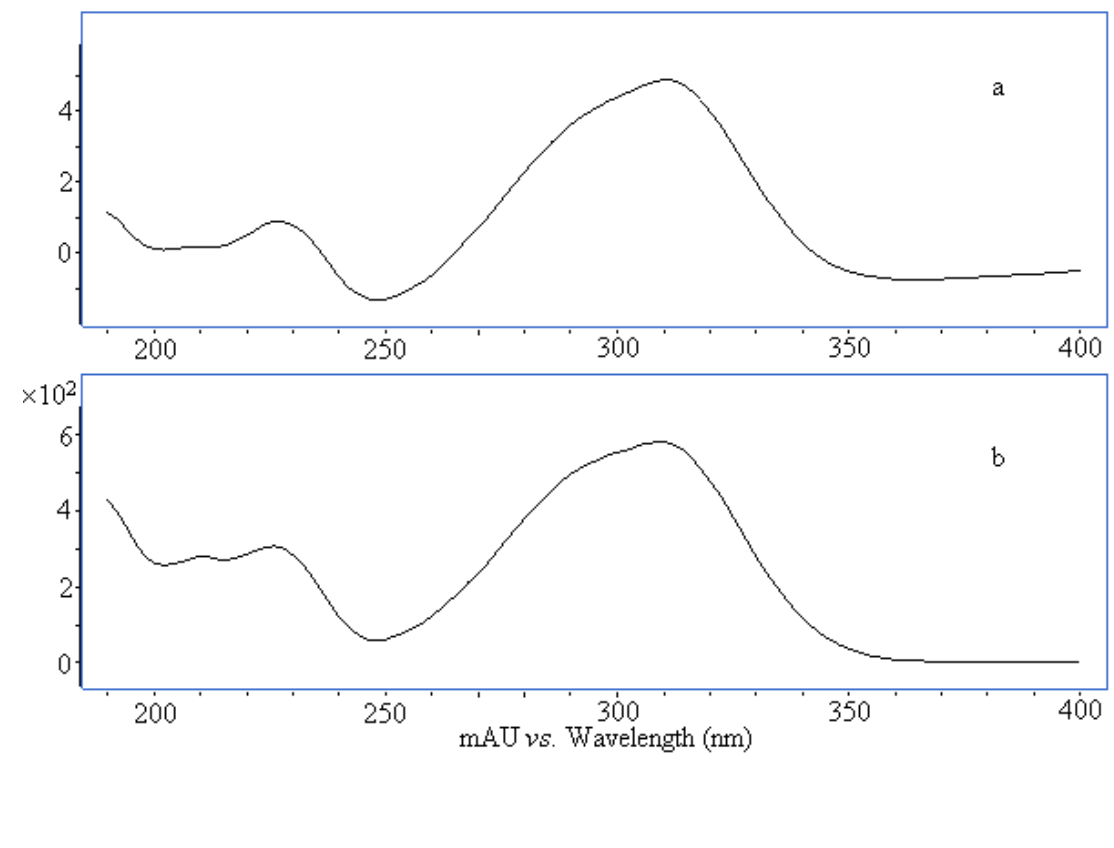
Figure 3. Comparison UV spectra of compound Ι ( a ) and p -coumaric acid ( b